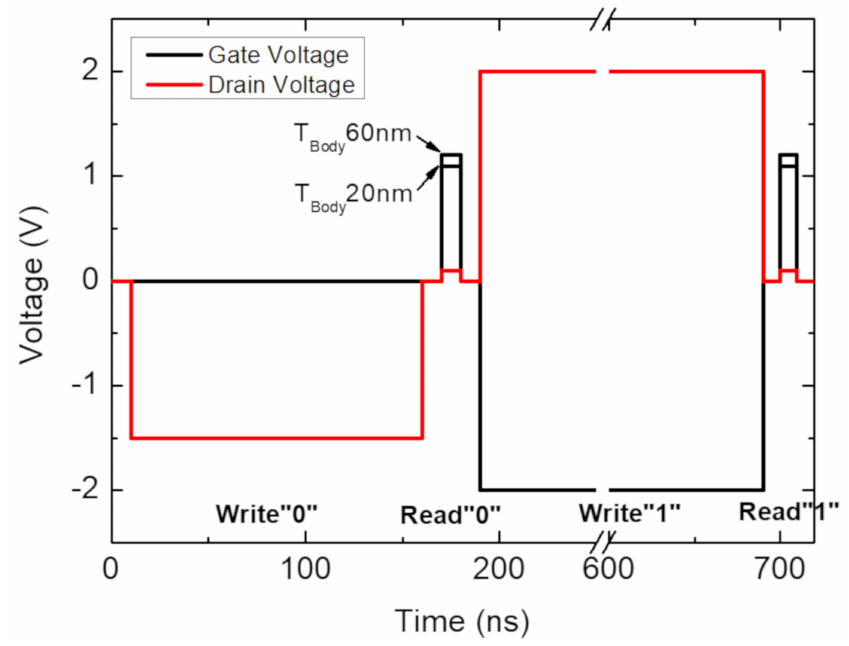
Figure 2. Simulation waveforms demonstrating poly-Si 1T-DRAM functionality. Table 2. Bias and time conditions for the transient operation of poly-Si 1T- DRAM